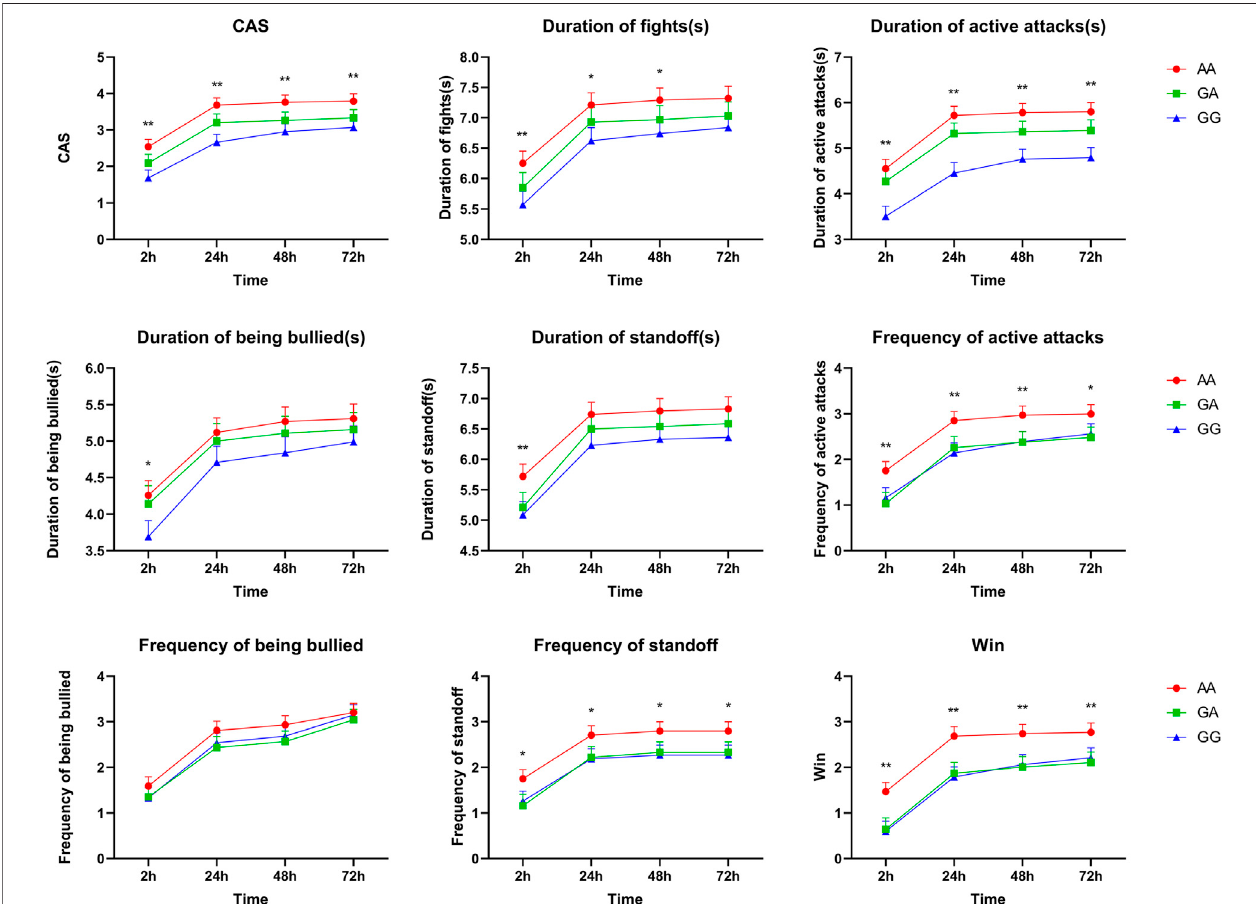
FIGURE 1 | Associations of SNP rs335052970 in the ARHGAP24 gene with aggressive behavioral traits at the fi rst 2, 24, 48, or 72 h after mixing in weaned pigs (LSM ± SE). * p < 0.05 and ** p < 0.01 indicate that the difference is signi fi cant.